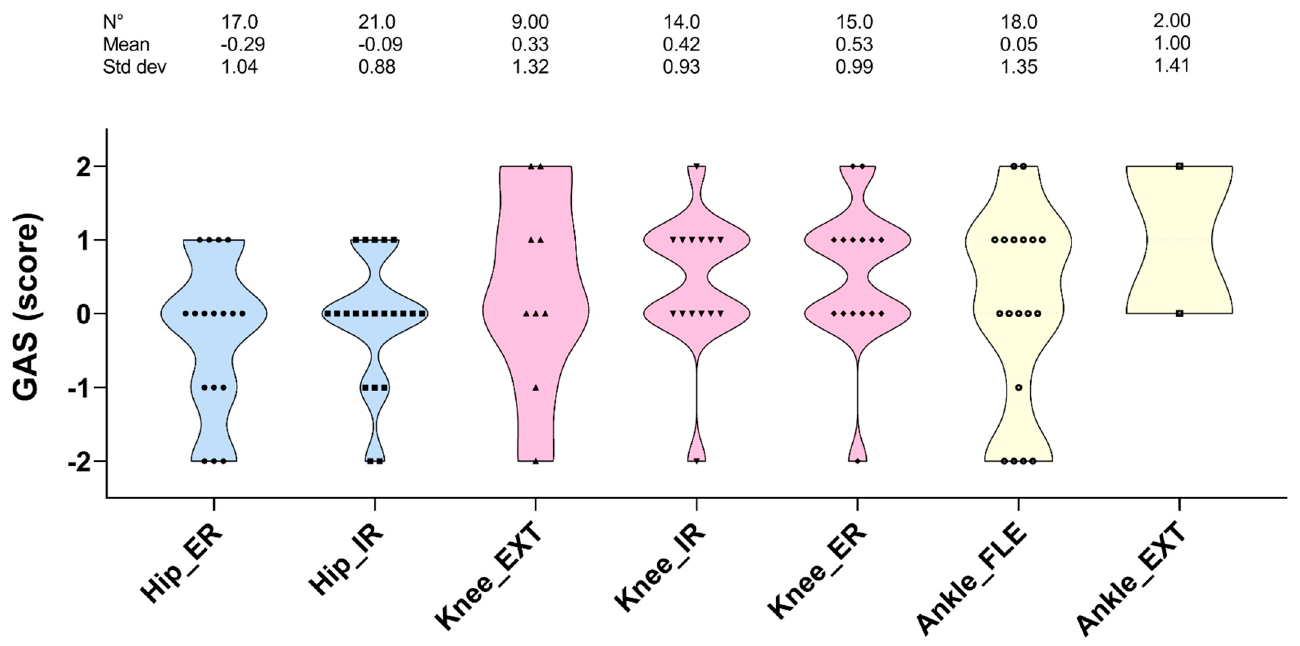
Figure 2. The violin plot graph shows the goal attainment scaling (GAS) score for the range of motion in the lower limbs, divided in hip, knee, and ankle districts after 11 weeks of precision-based exercise plus osteopathic treatment. Only children, adolescents, and young adults with medium or high adherence to the training sessions and osteopathic treatments were considered (see the method section for further details). ER and IR, external and internal rotation; EXT extension; FLE, flexion.